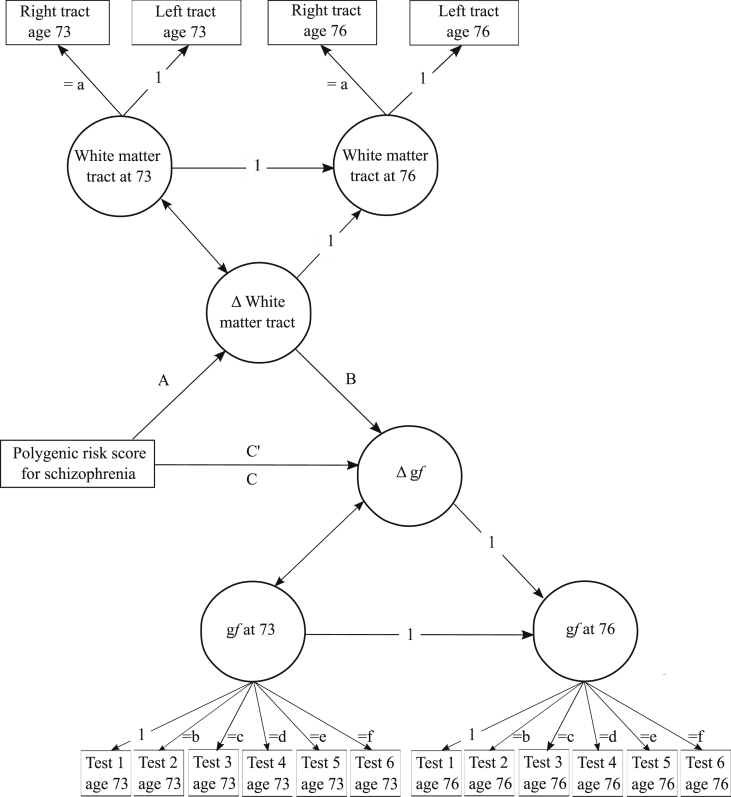
Diagram of the mediation model. The SEM model for white matter connectivity has been already described in Fig. 1. From each individual cognitive test, a latent score was calculated for general fluid intelligence (gf). From this model, a latent change score variable was calculated (Δ gf). Relation between polygenic risk score for schizophrenia (szPGRS) and change in white matter connectivity is indicated by path A; path B represents the association between change in white matter and change in gf. Path C represents the association between szPGRS and change in gf. C′ denotes the effect of szPGRS on change in gf when change in white matter connectivity is taken into account in the model.